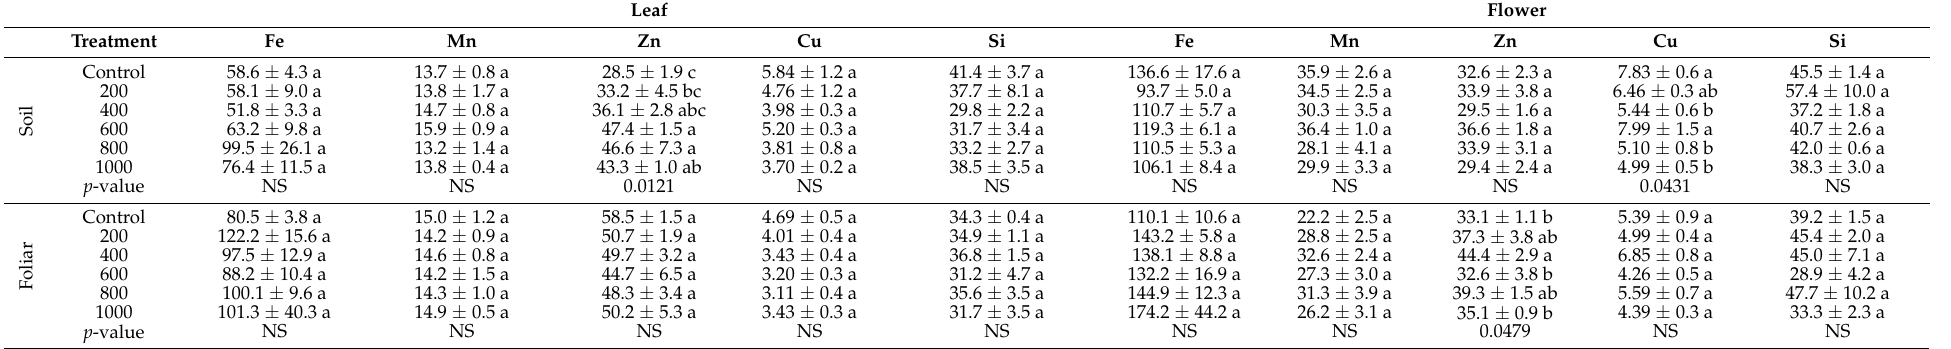
Table 2. Effect of the application of SiO 2 NPs on the concentration of micronutrients in leaves and flowers. Leaf